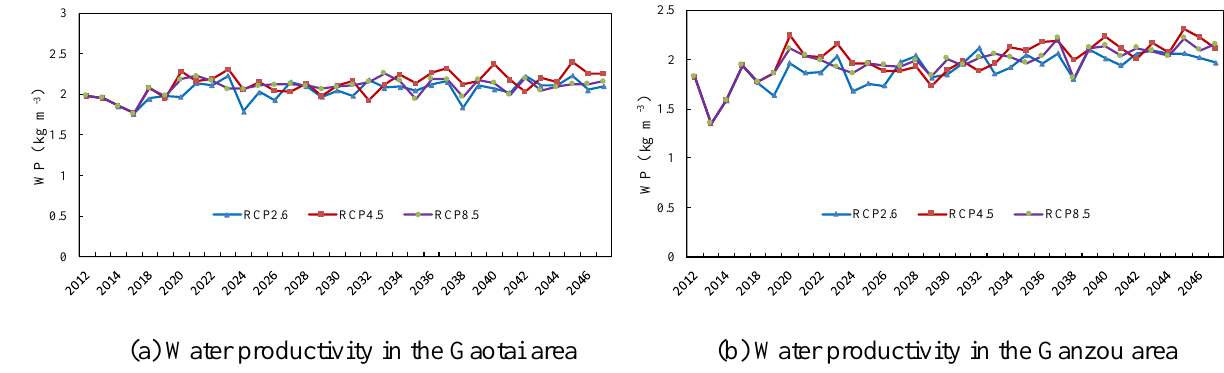
Figure 8. Temporal variations of corn water productivity in the middle agricultural region of the HRB under RCP scenarios.